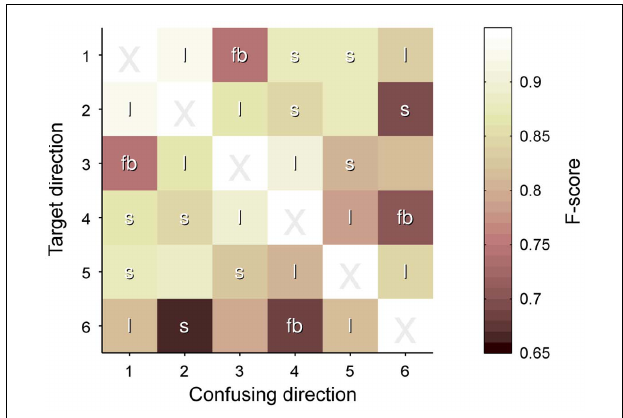
FIGURE 7 | Pairwise F -scores between speaker locations. The matrix visualizes the pairwise confusions between an intended location ( y axis) and a distracting location ( x axis), expressed in F -scores. Lighter colors mean better discrimination. Entries are labeled as l = location neighbor, s = sound neighbor, and fb = front–back symmetric